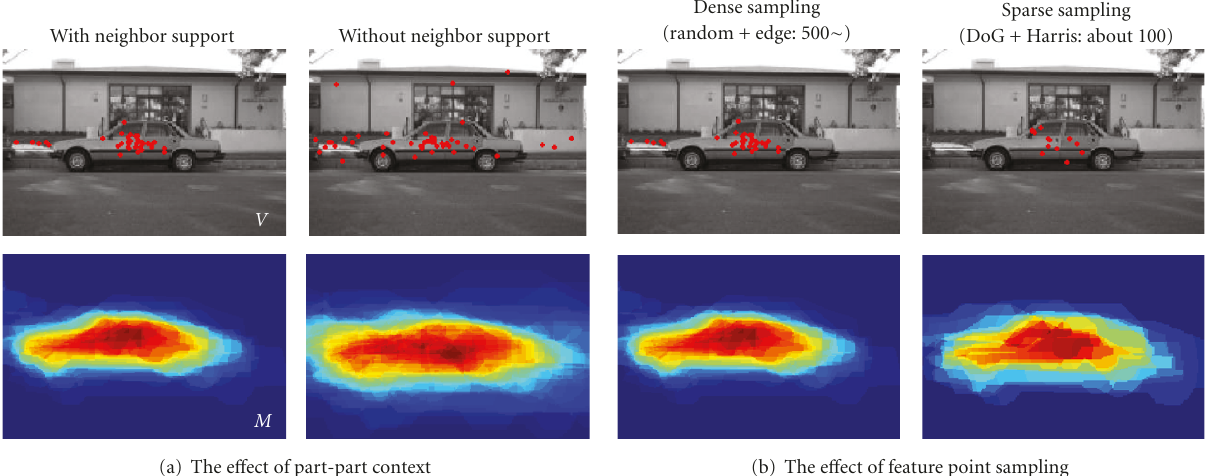
Figure 23: Properties of online boosting methods: (top row) estimated ROI (object center) points, (bottom row) accumulated figure/ground